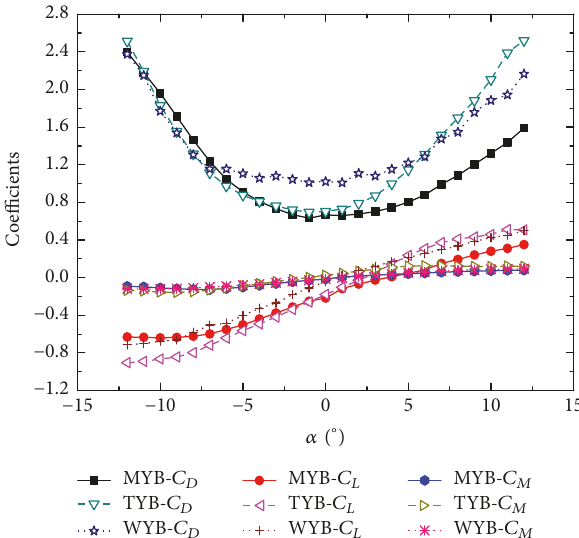
Figure 4: The aerodynamic coefficients of three bridge decks.